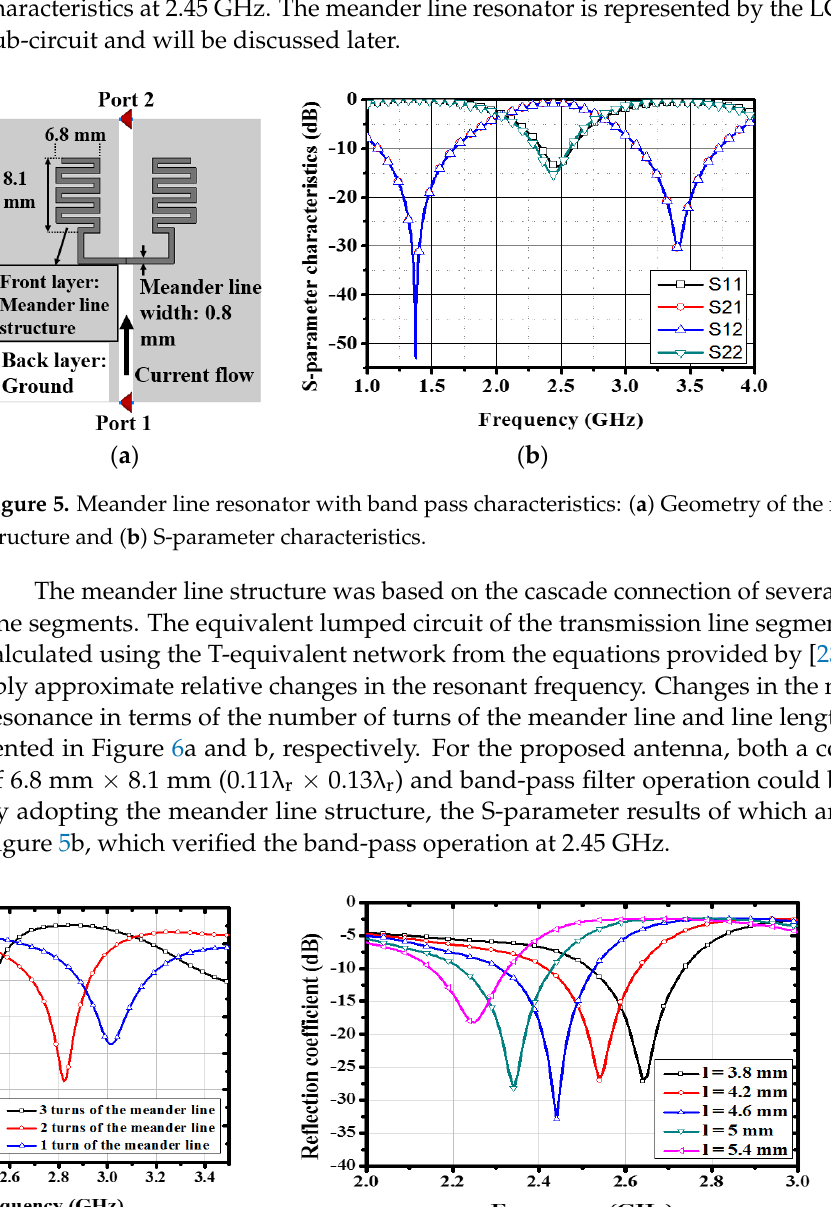
Figure 6. The reflection coefficient charts in terms of ( a ) the number of turns and ( b ) the vertical length of the meander line.